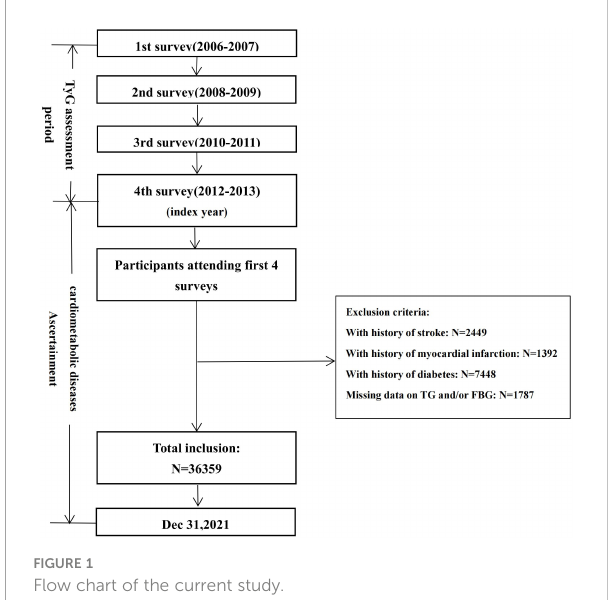
FIGURE 1 Flow chart of the current